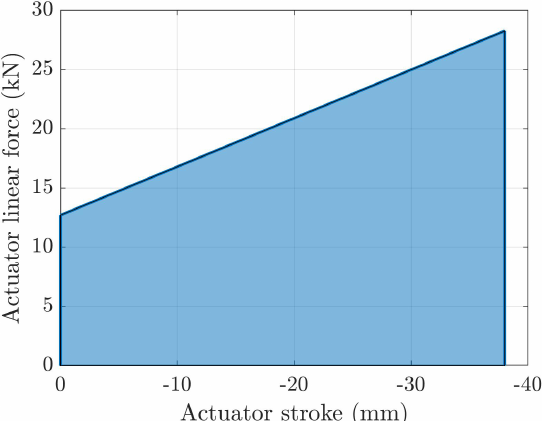
Figure 18. Actuator linear force as a function of the stroke for downward deflection.